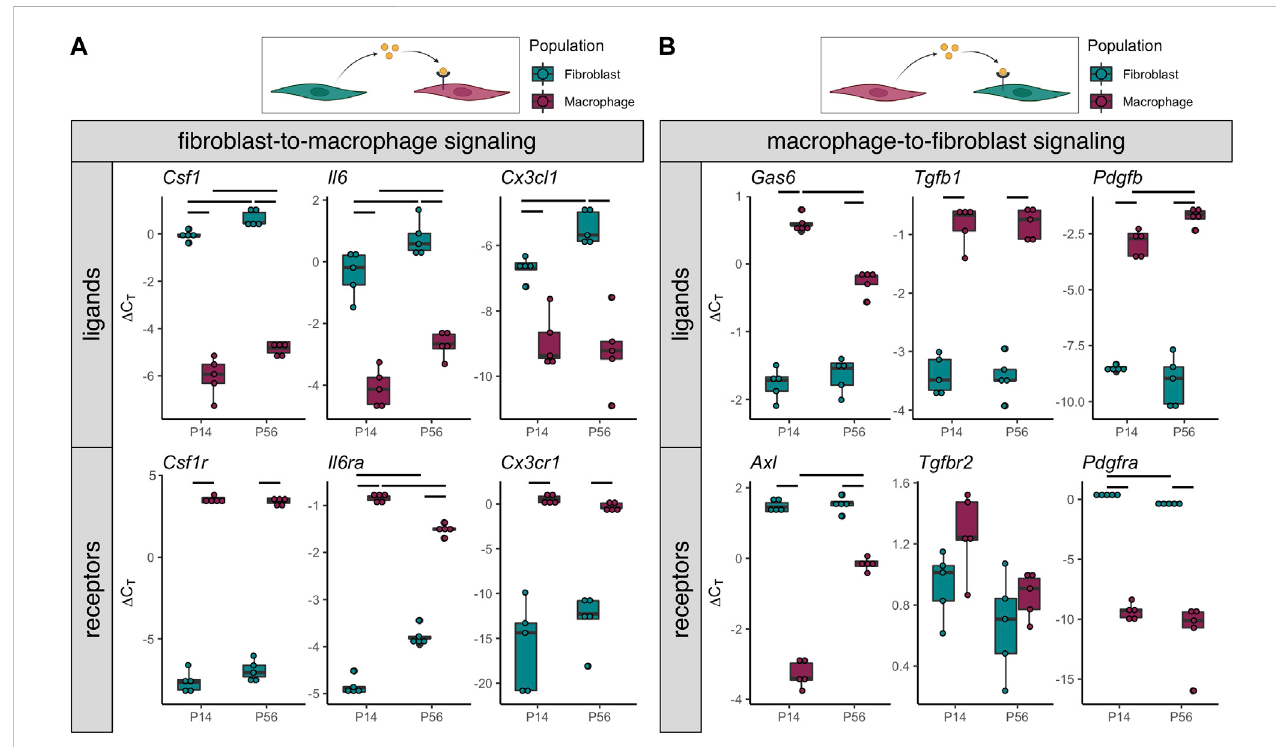
FIGURE 5 Gene expression indicates potential tendon resident macrophage- fi broblast crosstalk (A) Δ C T levels of ligands enriched in tdTomato + fi broblasts (top) andreceptorsenrichedinF4/80-BrilliantViolet421 + macrophages(bottom)fromP14andP56limbtendons( n =5) (B) Δ C T levelsofligandsenrichedinF4/80- Brilliant Violet 421 + macrophages (top) and receptors enriched in tdTomato + fi broblasts (bottom) from P14 and P56 limb tendons ( n = 5). Signi fi cance bars indicate p < 0.05 as determined by Mann-Whitney U